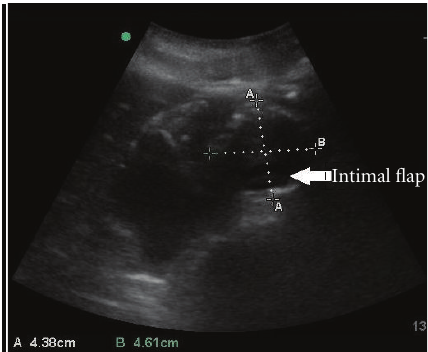
Figure 1: Abdominal ultrasonography demonstrating intimal flap (arrow).